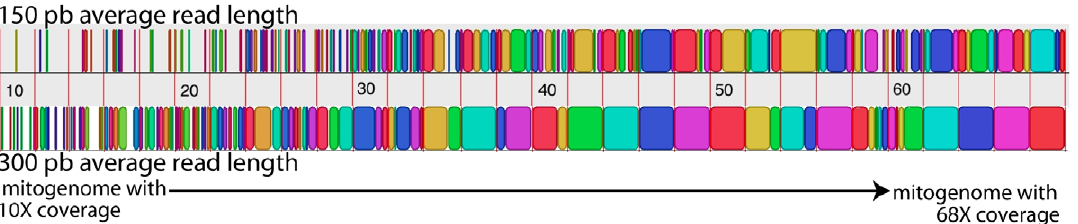
Figure 4. Comparison of the 30 original mitogenomes with the contigs assembled from the Ion Torrent simulations. Upper part represents contigs resulting from reads with 150 pb mean length, lower part contigs assembled from reads of 300 bp mean length. Orange lines indicate the limits of the mitogenomes; these are ordered from the one with least coverage (10 6 , on the left) to the most covered mitogenome (58 6 , on the right). Coverage of the mitogenomes are by steps of an increment of 2 6 (scale indicates the coverage). The same dataset was used to generate the 150 and the 300 bp reads. Contig colors have no meaning beyond ease of visualization. Generated using outputs of the genome alignement program MAUVE